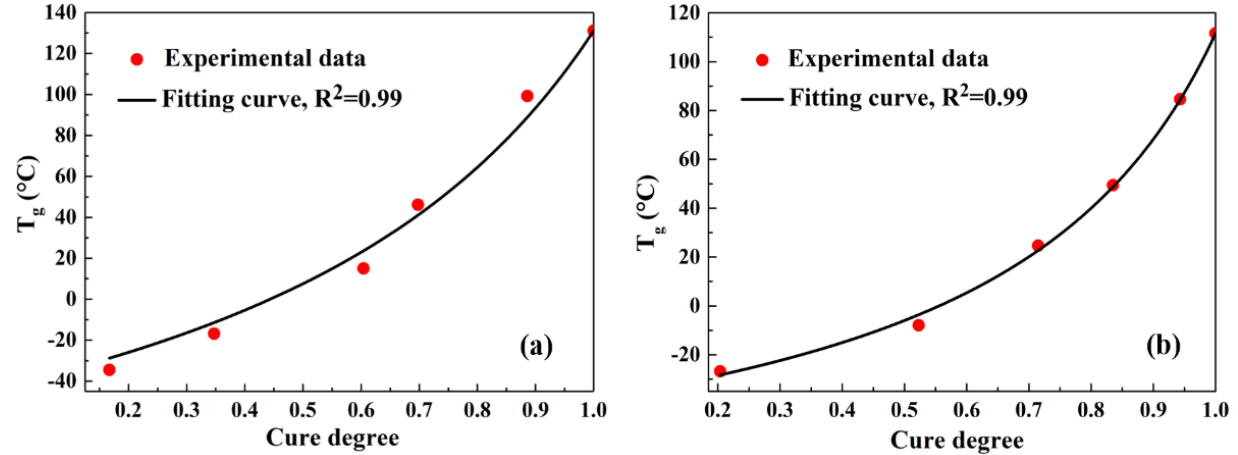
Figure 4. DiBenedetto equation fitting curves of the relationship between α and T g of ( a ) the unfilled matrix resin and ( b ) Ag-filled ICA.